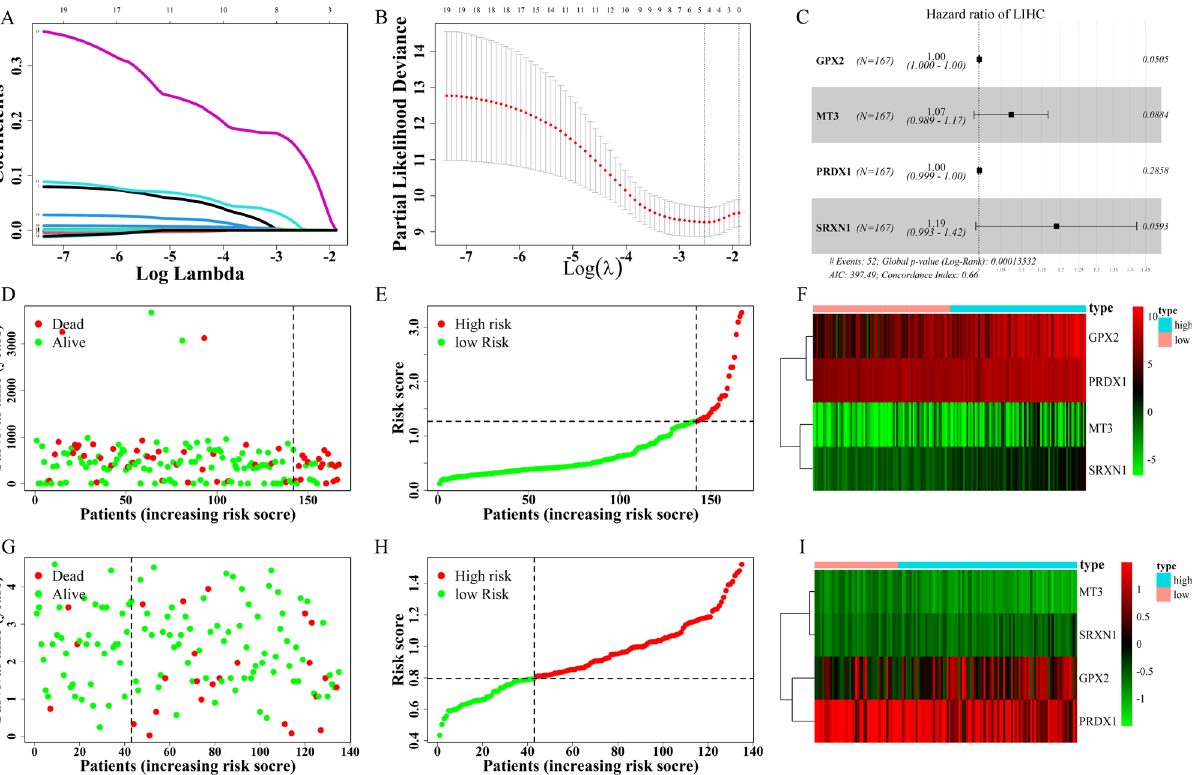
Figure 3. The process of building the prognostic gene signature and a signature-based risk score is a promising marker in TCGA and International Cancer Genome Consortium (ICGC) cohorts. ( A ) Distribution of LASSO coefficients of the 19 ferroptosis-related potential prognostic genes in the training cohort. ( B ) The generated coefficient distribution plots for the logarithmic (lambda) sequence for the selection of the best parameter (lambda). ( C ) Forest plot showing the ferroptosis-related gene associated with the survival of patients with hepatocellular carcinoma. ( D–I ) The left represents the survival status of patients in the training ( D ) and validation ( G ) cohorts; the center represents the distribution of the risk score in the training ( E ) and validation ( H ) cohorts; the right represents the expression pattern of the prognostic signature genes in the classifiers of the high- and low-risk groups in the training ( F ) and validation ( I )